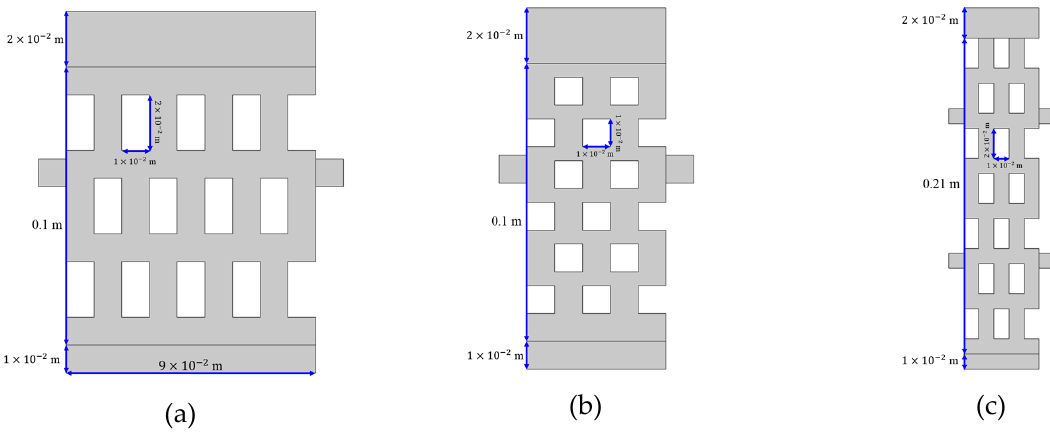
Figure 17. Schematic diagrams of mixing chambers with: ( a ) a long width of 9 × 10 − 2 m; ( b ) smaller obstacles (1 × 1 × 10 − 4 m 2 ); and ( c ) a long length (0.21 m) and two plasma inlets.